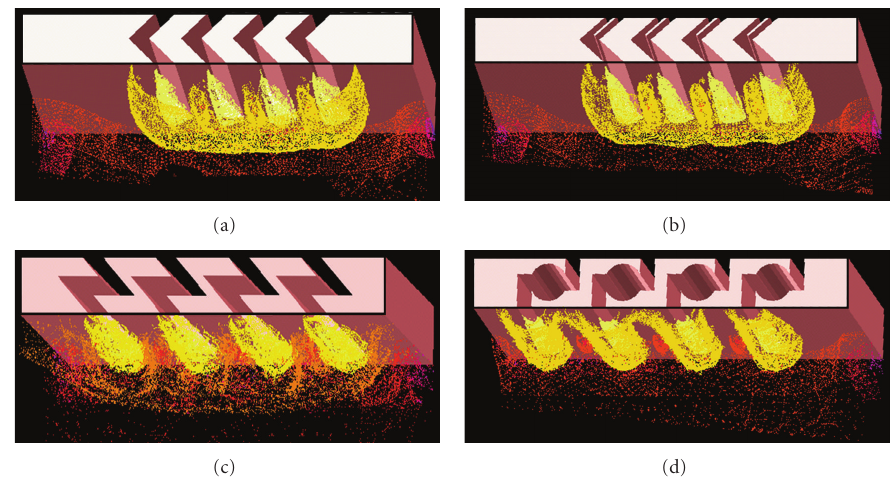
Figure 5: Transparency of the various slot structures to the RF magnetic field. The distribution of the RF electromagnetic energy density at the exit from slot due to (a) chevron, (b) chevron with a thin blade, (c) “ Z -slot” structure, and (d) double L with cavity